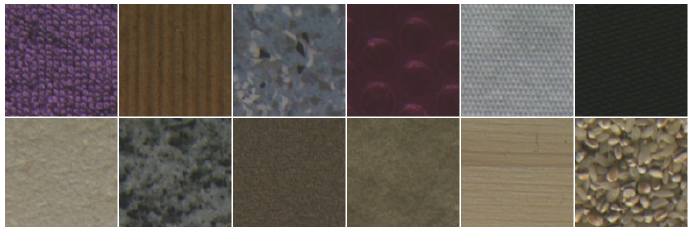
Figure 5. Samples from the Outex dataset among the 68 color texture classes. Each of the 12 surface categories (from top-left to bottom-right: canvas, cardboard, carpet, foam, paper, rubber, tile, granite, sandpaper, wool, wood, and barley-rice) included in this dataset is represented herein by one image.